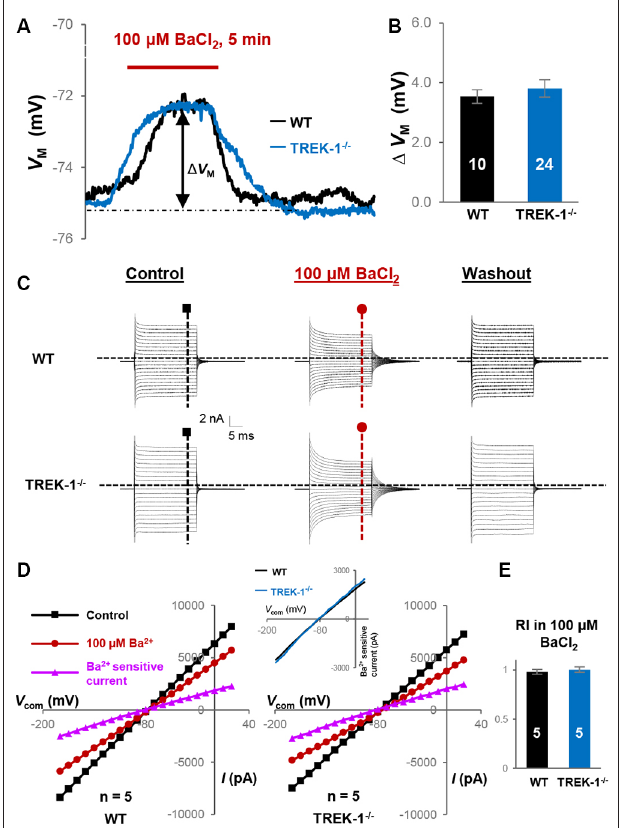
FIGURE 3 | K ir4.1 inhibition does not reveal the functional contribution of TREK-1 in TREK-1 − / − astrocytes. (A) Representative V M response to K ir 4.1 inhibitor 100 µ M BaCl 2 from a WT and a TREK-1 − / − astrocyte, as indicated in situ . ∆ V M indicates the peak V M depolarization during a 5 min BaCl 2 bath application. (B) Summary of 100 µ M BaCl 2 -induced V M depolarization, where the V M depolarization was comparable between WT and TREK-1 − / − astrocytes. (C) Representative whole-cell current recorded first in control, then 5 min in 100 µ M BaCl 2 , and washout. (D) I-V plots derived from recordings in (C) . The Ba 2 + -sensitive currents in I-V plots were obtained from sweep subtraction. The Ba 2 + -sensitive currents were shown in expanded y -axis in the inset that showed a moderate inward rectification in both WT, RI = 0.91, and TREK-1 KO, RI = 0.90, respectively. (E) Summary of RI values from WT and TREK-1 − / − astrocytes obtained from recordings in the presence of 100 µ M BaCl 2 for K ir 4.1 inhibition; the RI values were comparable between the two